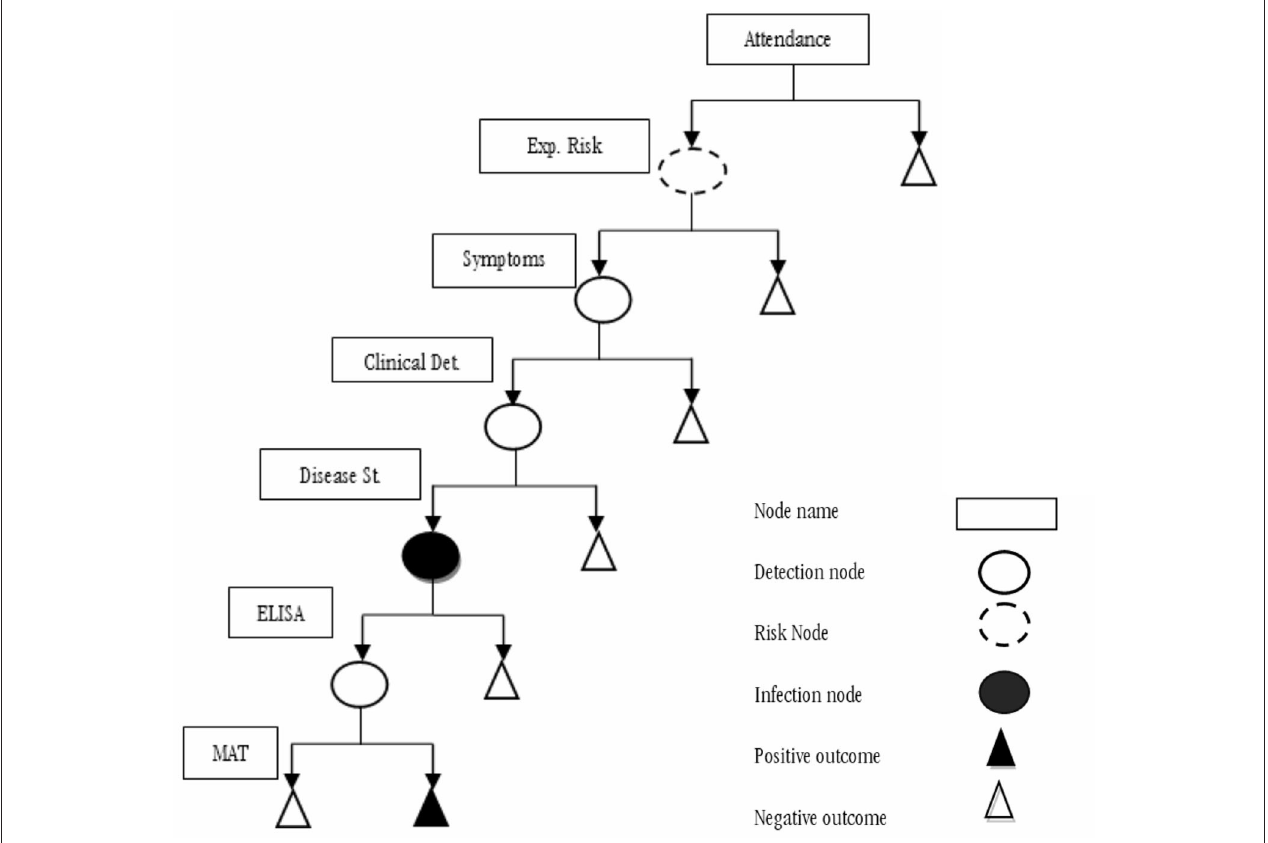
FIGURE 1 | Scenario tree model representing the current national human leptospirosis surveillance system in Ecuador.